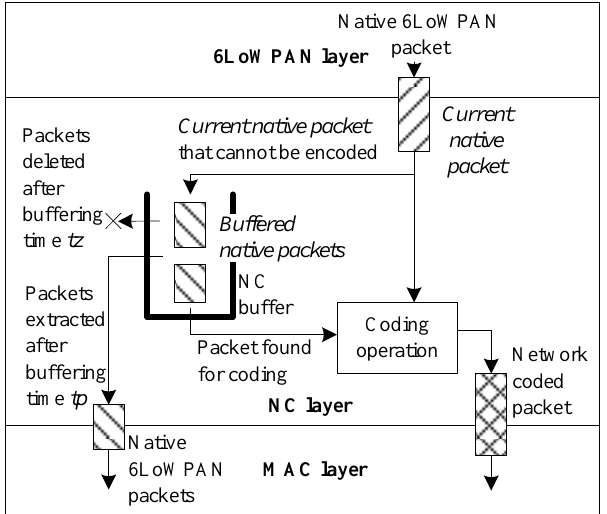
Figure 4. Network coding scheme in intermediate nodes.